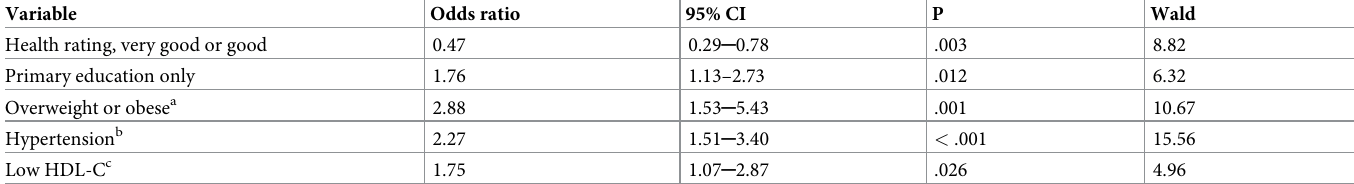
Table 5. Multivariable analysis of factors associated with pre-diabetes according to diagnosis by FPG using ADA classification.